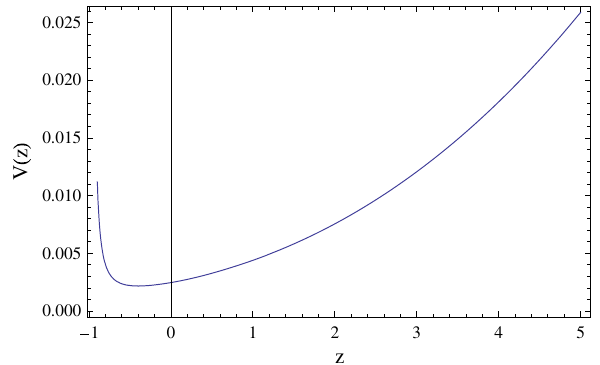
Fig. 27 Variation of q ( z ) with the variation of z (Model IV) by con- sidering the best fit values w 0 = − 0 . 766 ,w 1 = 0 . 307